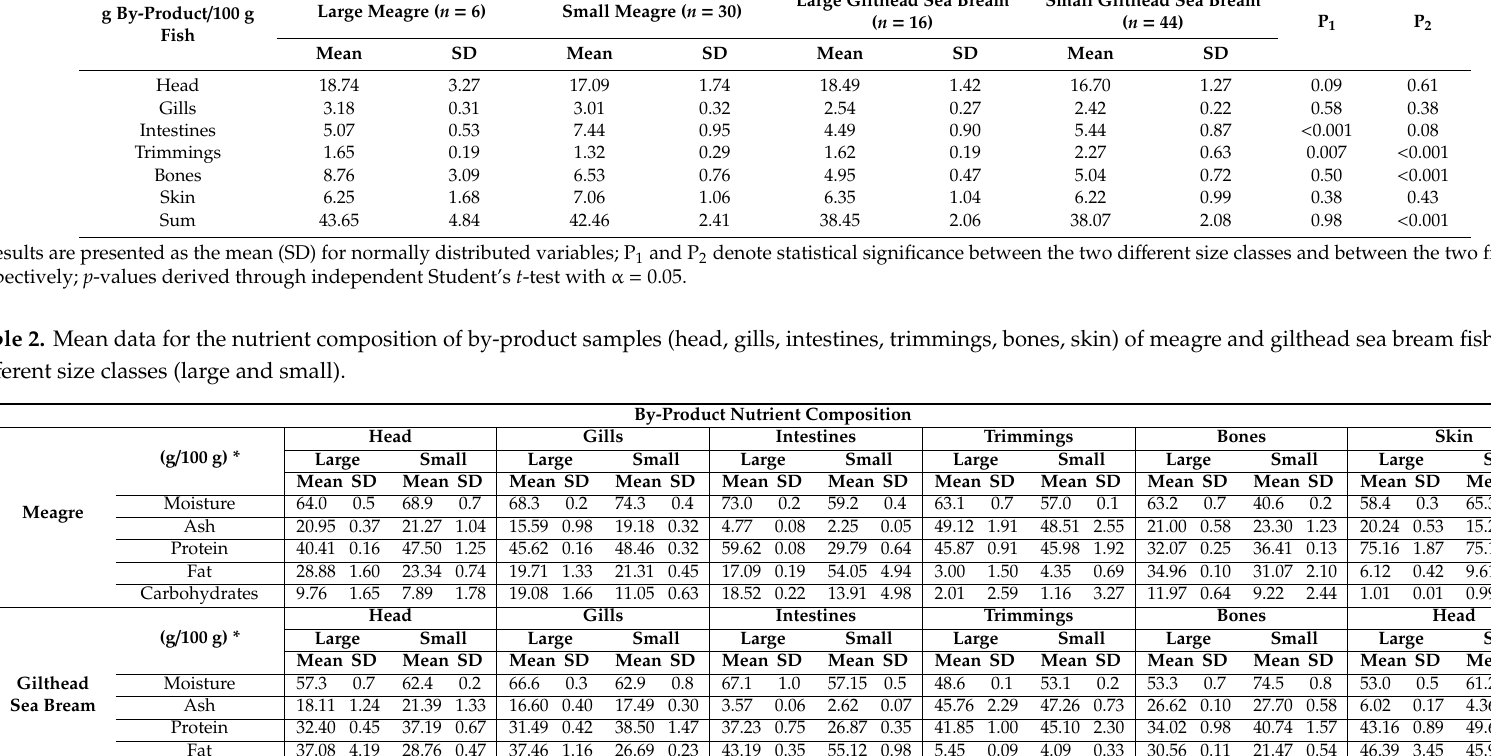
Table 1. Percentage weight 1 of the six di ff erent by-products (intestines, gills, trimmings, head, skin) of meagre and gilthead sea bream in two di ff erent size classes. g By-Product / 100 g Fish